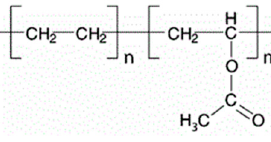
Figure 12. Chemical structure of EVA [119].